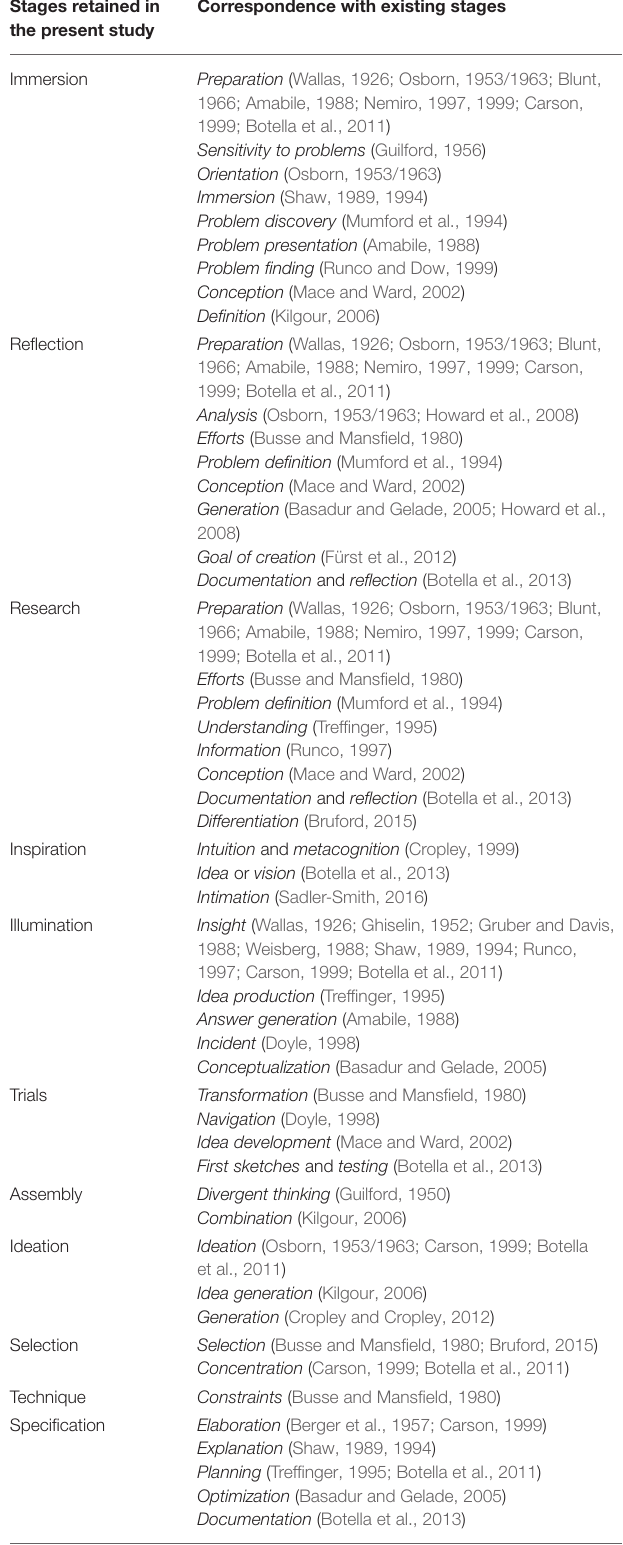
TABLE 5 | Correspondence between the stages retained in the present study and the existing stages in research field. Stages retained in the present